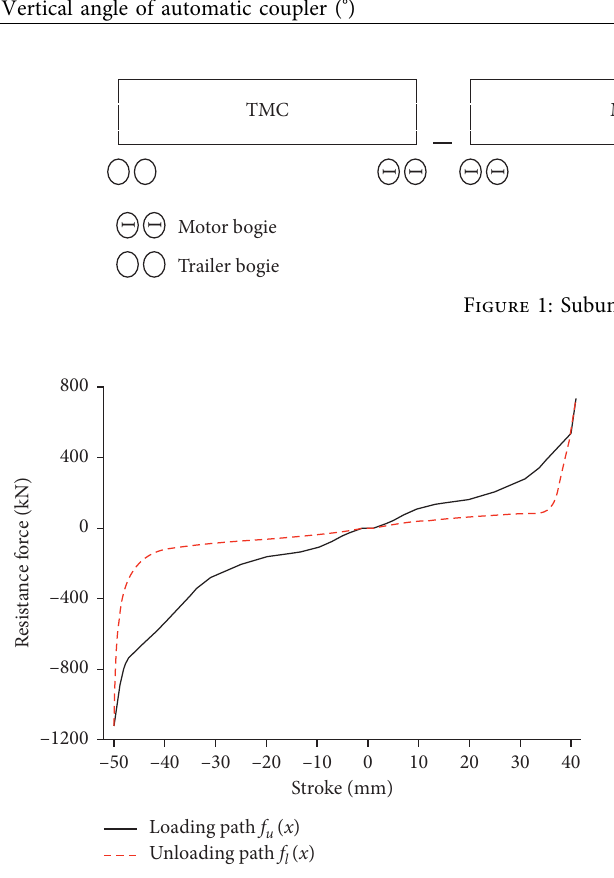
Figure 2: Draft gear